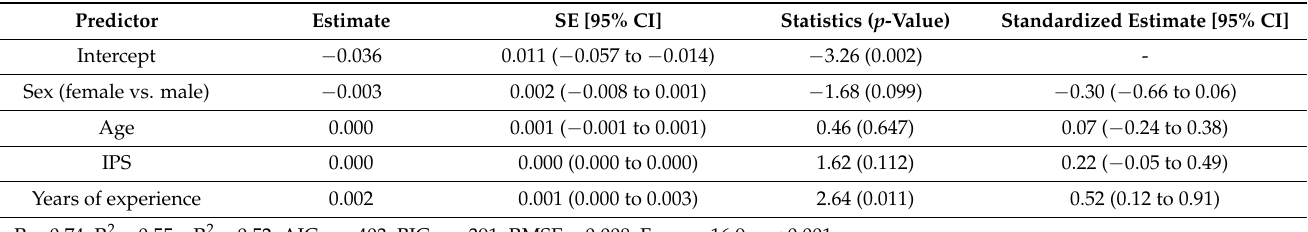
Table 3. The multivariate regression analysis sheds light on the determinants of the change in performance due to verbal encouragement. Abbreviation: AIC, Akaike information criterion; aR 2 , adjusted R-squared; BIC, Bayesian information criterion; CI, confidence interval; F-test, overall model fit test; IPS, International Point Score; R 2 , R-squared; RMSE, root-mean-square error; SE, standard